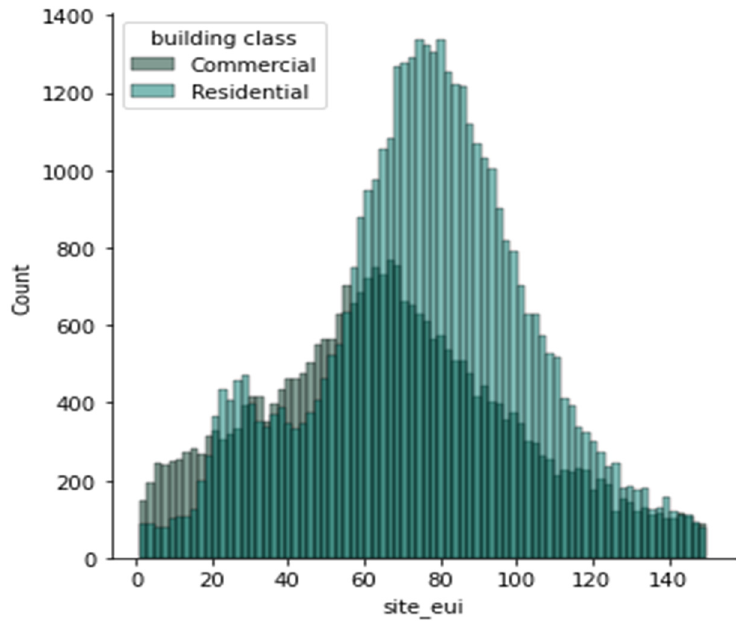
Figure 3. Data distribution with respect to energy utilization and building class. Figure 3 . Data distribution with respect to energy utilization and building class.